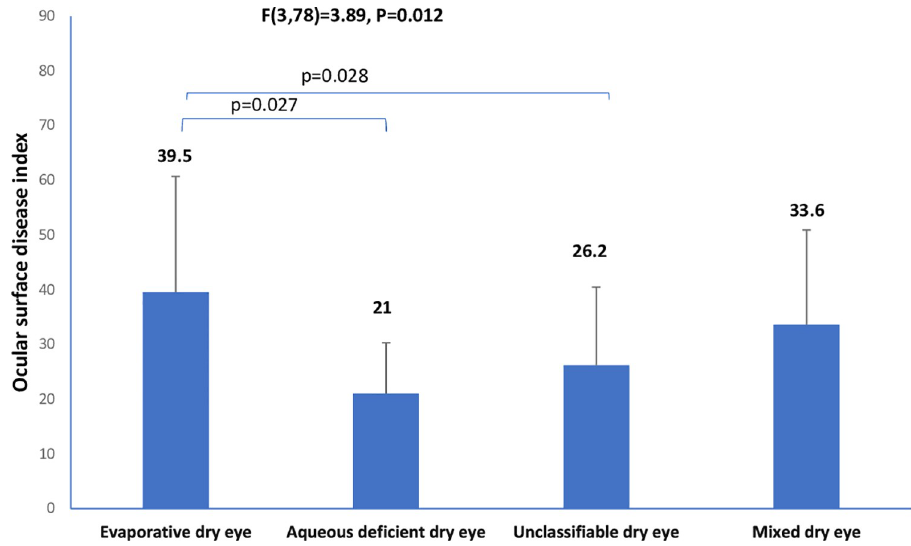
Fig 4. Means of ocular surface disease index across clinical subtypes of dry eye.